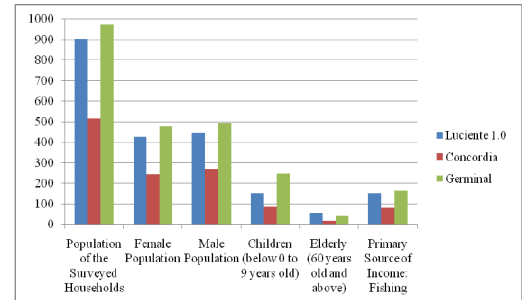
Figure 8. The population statistics of the three barangays.